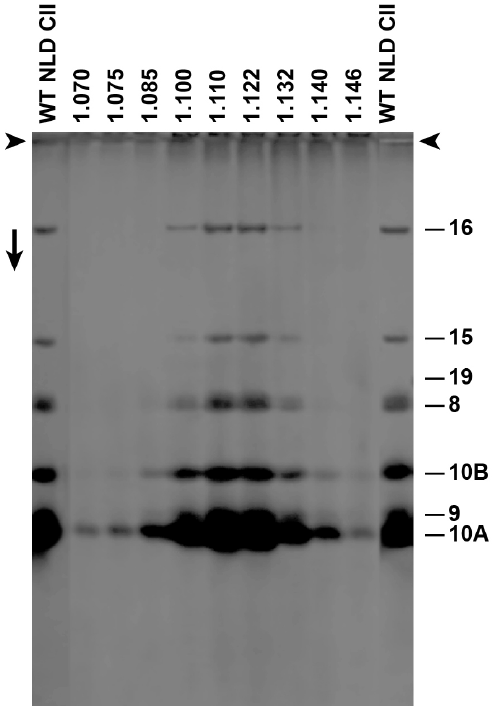
Figure 3. Sodium dodecyl sulfate polyacrylamide gel electrophoresis (SDS-PAGE) of Nycodenz low-density (NLD) incompletely packaged DNA (ipDNA)-capsids ( F = 0.27–0.31). Densities (g/mL) of Nycodenz fractions are above lanes. Number of protein [19] is at the right. WT NLD CII = wild type NLD capsid II; arrowheads indicate origins; the arrow indicates electrophoretic direction.